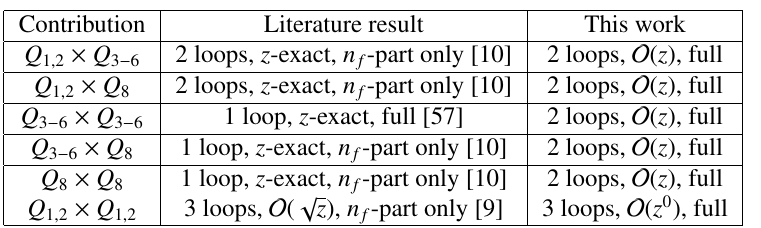
Table 1. Overview of the results obtained in the course of this